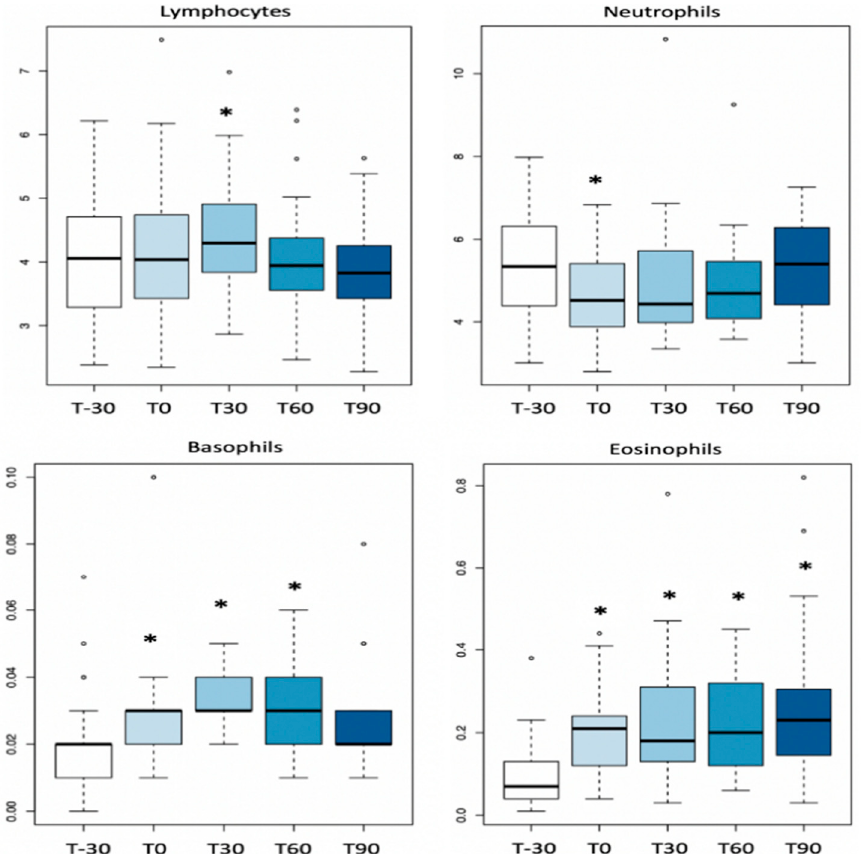
Figure 1. Boxplot with significant CBC parameters in the time series. Circles in the plot area represent outliers. Asterisks (*) in the plot area represent time points that statistically differ from T-30. Table 2. Means ± SD of completed blood count (CBC) parameters. Parameters significantly modified compared with T-30 are indicated in bold.